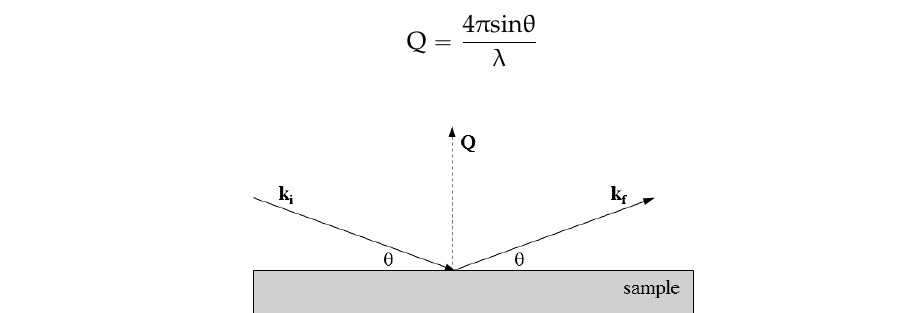
Table 1. List of samples for the Fe/Nb and W/Nb measurements. The description in the brackets is the thickness of each layer in a single bilayer. The number in subscript represents how many times each bilayer was repeated.